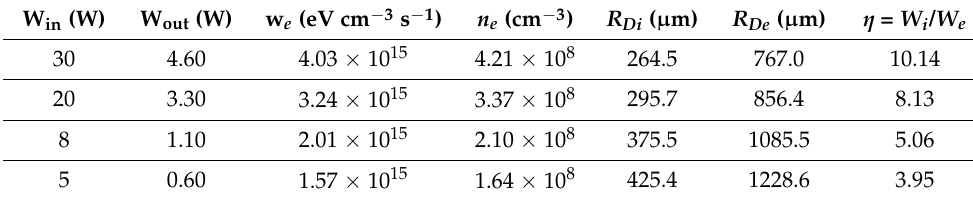
Table 2. Parameters of the RF discharge in the second series of experiments at the fixed pressure P = 5 Pa ( E/N = 107.9 Td, T e = 4.478 eV, l e = 1.297 cm, l i = 0.05 cm).